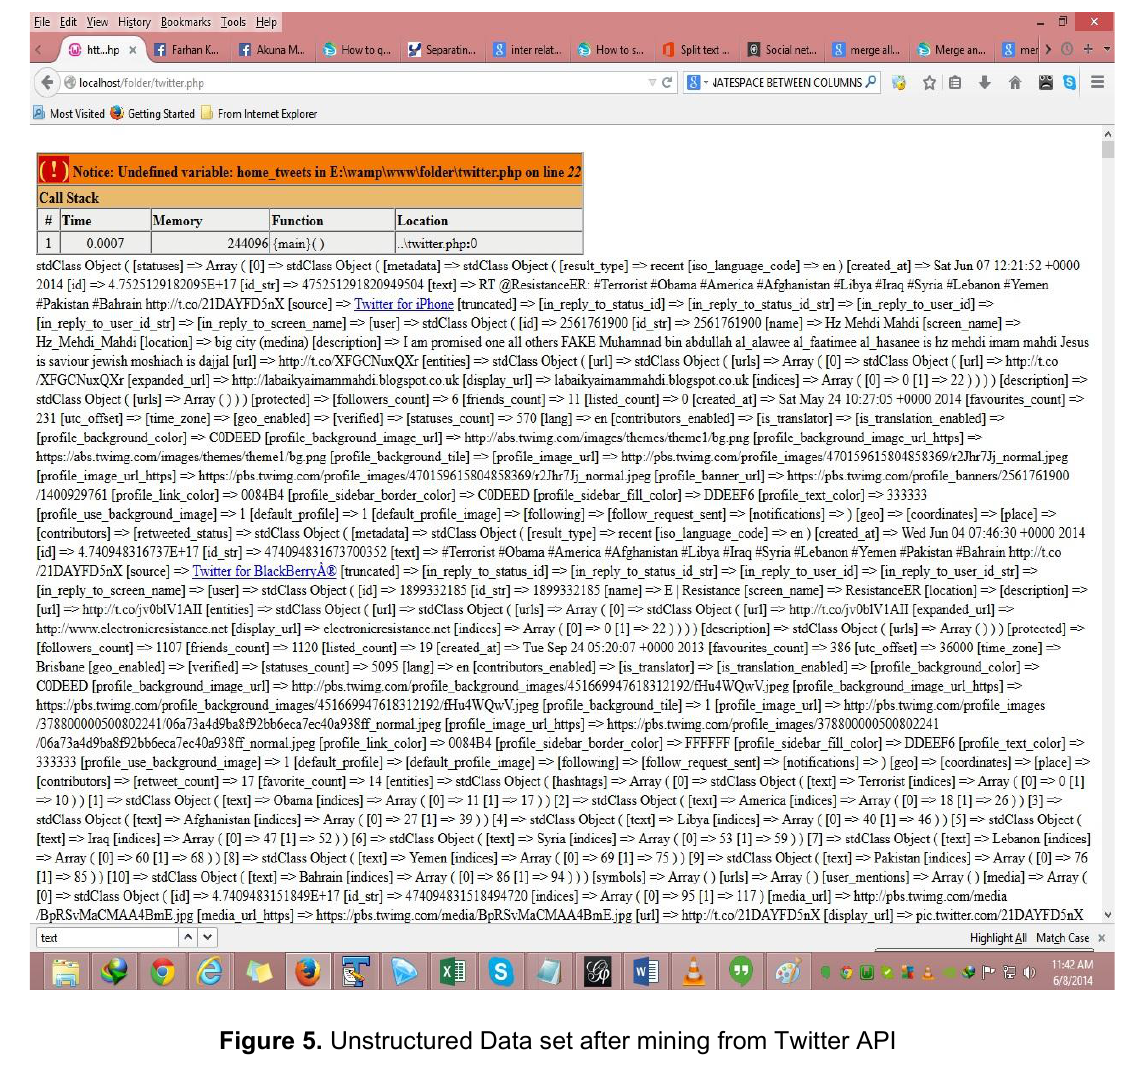
After the filtration of Data through Google refine. We have mapped the data into Gephi by using Force Atlas 2 algorithm for the proper Structuring of Data and make the relationships of the key Players and identify different groups behind the terrorism in Syria and their connection with other countries. In this paper, we also mapped the countries to check the connection one of the countries with one another for the connection between